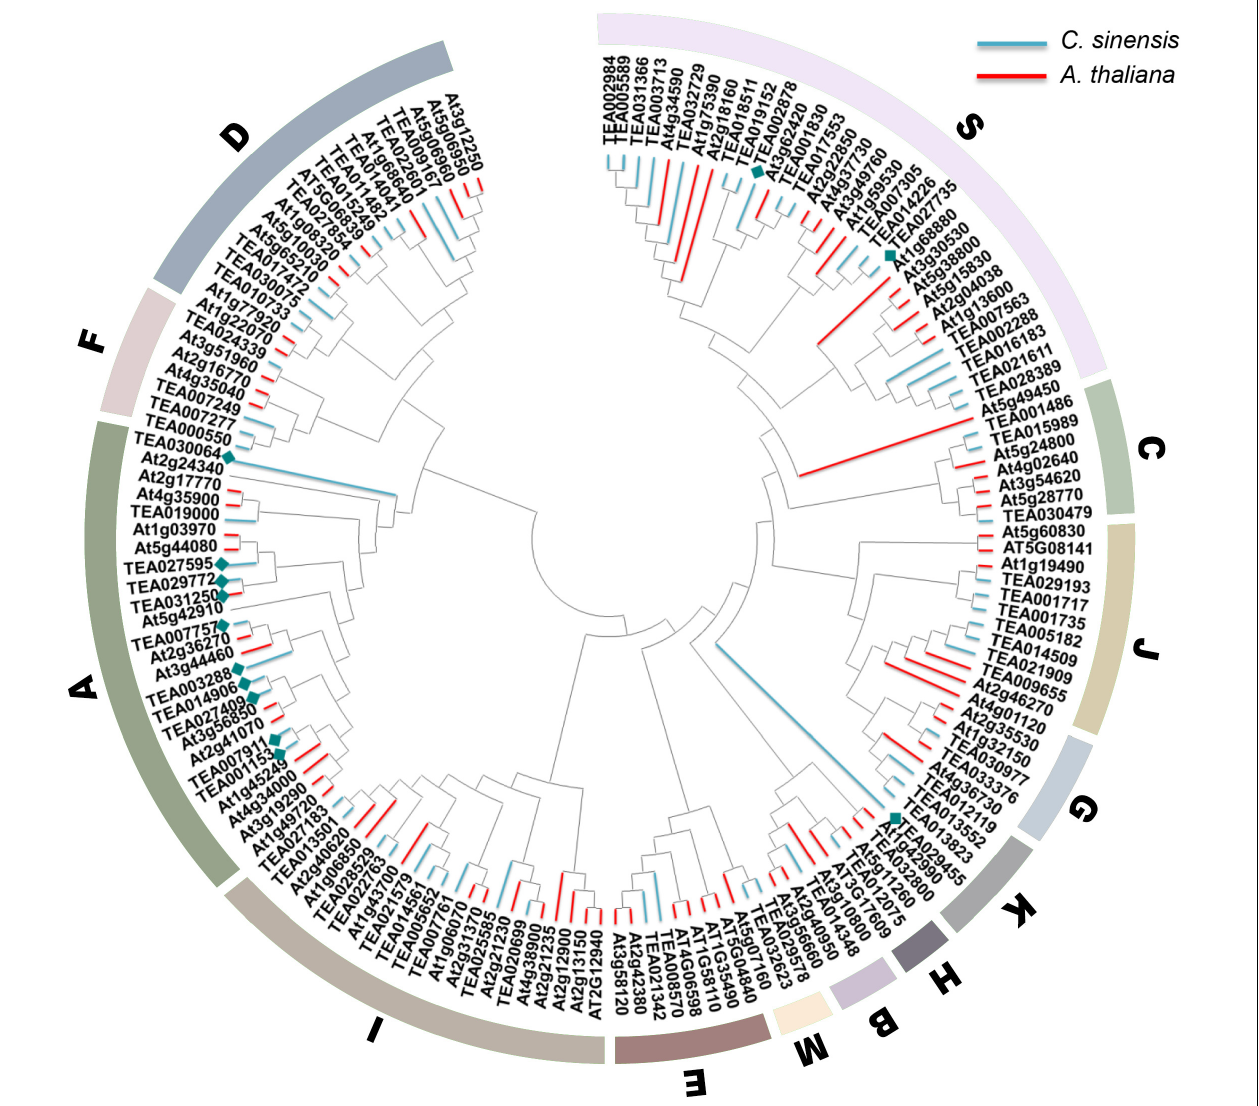
FIGURE 1 | Phylogenetic tree. Consensus tree of bZIP proteins from Camellia sinensis and Arabidopsis thaliana . The conserved domain sequences were aligned by DNAMAN, and the phylogenetic tree was constructed using MEGA 7.0 by the neighbor-joining (NJ) method with 1,000 bootstrap replicates. Molecular analyses divided the bZIP into thirteen distinct clades. Clades A–K, M, and S are indicated by the colored areas. Blue lines represent CsbZIP, pink lines represent AtbZIP, and blue diamond represent the CsABF genes family